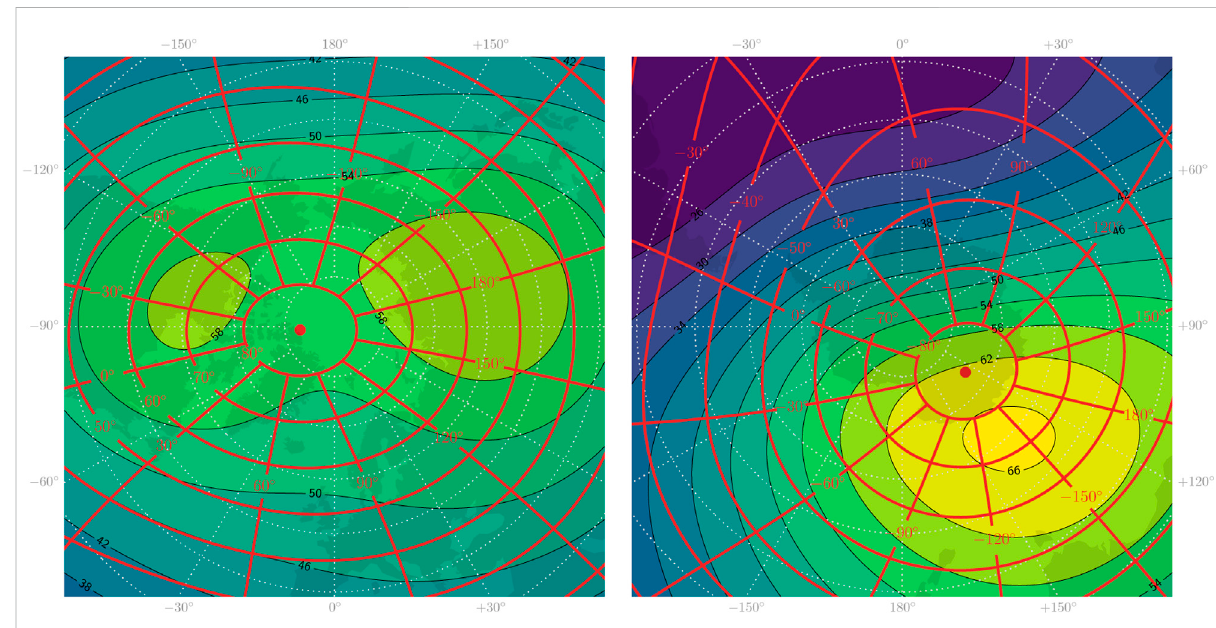
FIGURE 1 Illustration of the differences in Earth ’ s magnetic fi eld in the north (left) and south (right). The colored contours show the IGRF main fi eld magnitude at epoch=2015.0 with contour levels labeled in μ T . The red curves represent magnetic apex coordinate grids. Both plots are stereographic projections of an equally large area, centered at the geographic poles. Geographic longitudes are indicated at the